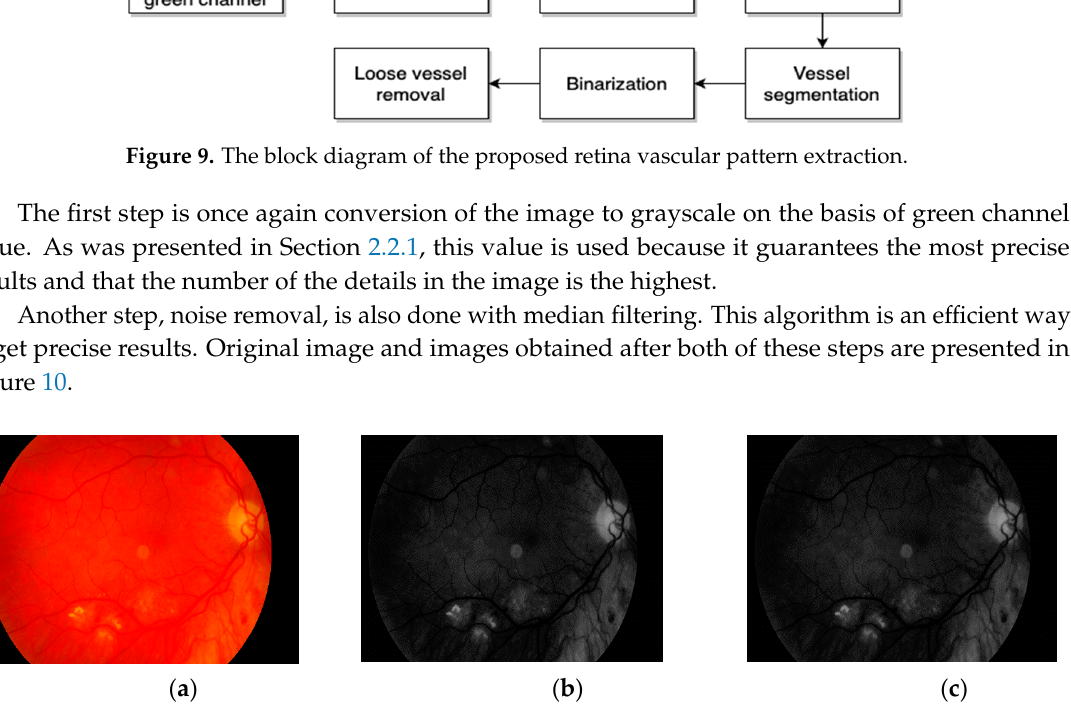
( b ) Figure 7. Image after ( a ) histogram stretching and ( b ) median filtering. The last step of the image preprocessing stage is gamma correction. Retina color images can be represented in different levels of brightness (from bright red to even blood red). This fact requires us to unify the color of the image. This was done with a gamma correction method, described in [37]. The gamma parameter value was calculated as in (2). Each pixel was multiplied by the gamma value. The result of this step is presented in Figure 8. 𝛾 = −0,3 𝑙𝑜𝑔 (cid:2869)(cid:2868) 𝑋 (2) where X is the mean pixel value calculated on the basis of all pixels in the image. ( a ) ( b ) Figure 8. Image ( a ) after median filtering and ( b ) after gamma correction. This step ends the image preprocessing stage. The image is now moved to another module that extracts the vascular pattern. Another stage will concern vascular pattern and optic disk removal. 2.2.2. Retina Vascular Pattern Extraction